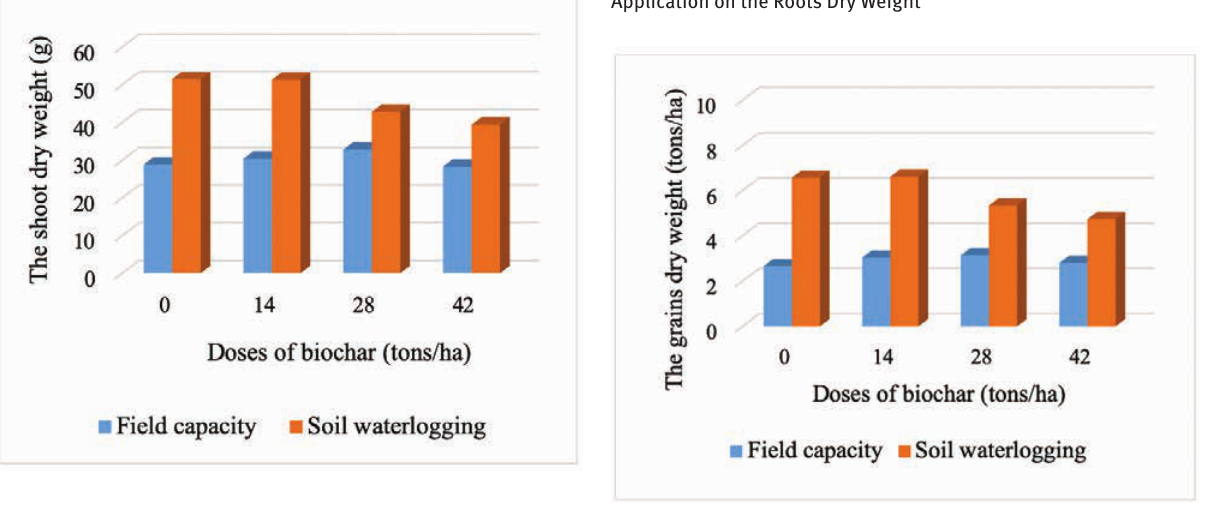
Figure 2: The Interaction between Soil Water Content and Biochar Application on the Roots Dry Weight